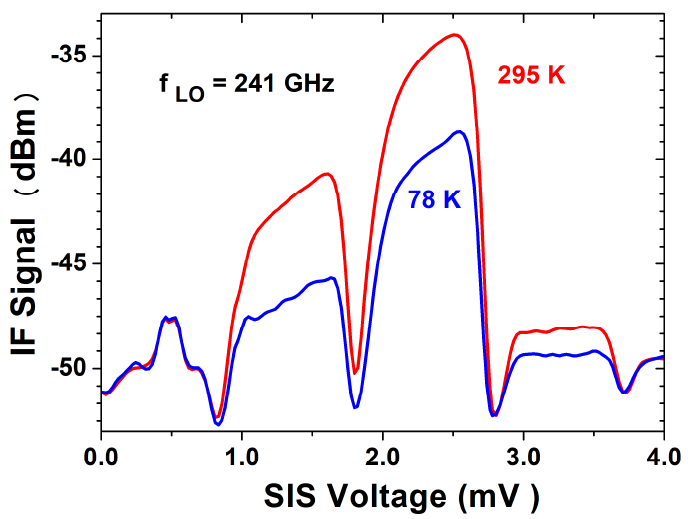
Figure 9. The output signal of the SIS receiver at intermediate frequency (IF) 6.5 GHz on the SIS bias voltage, measured for the cold and hot input loads (78 K—blue curve and 295 K—red curve, correspondingly) at the local-oscillator frequency 241 GHz.